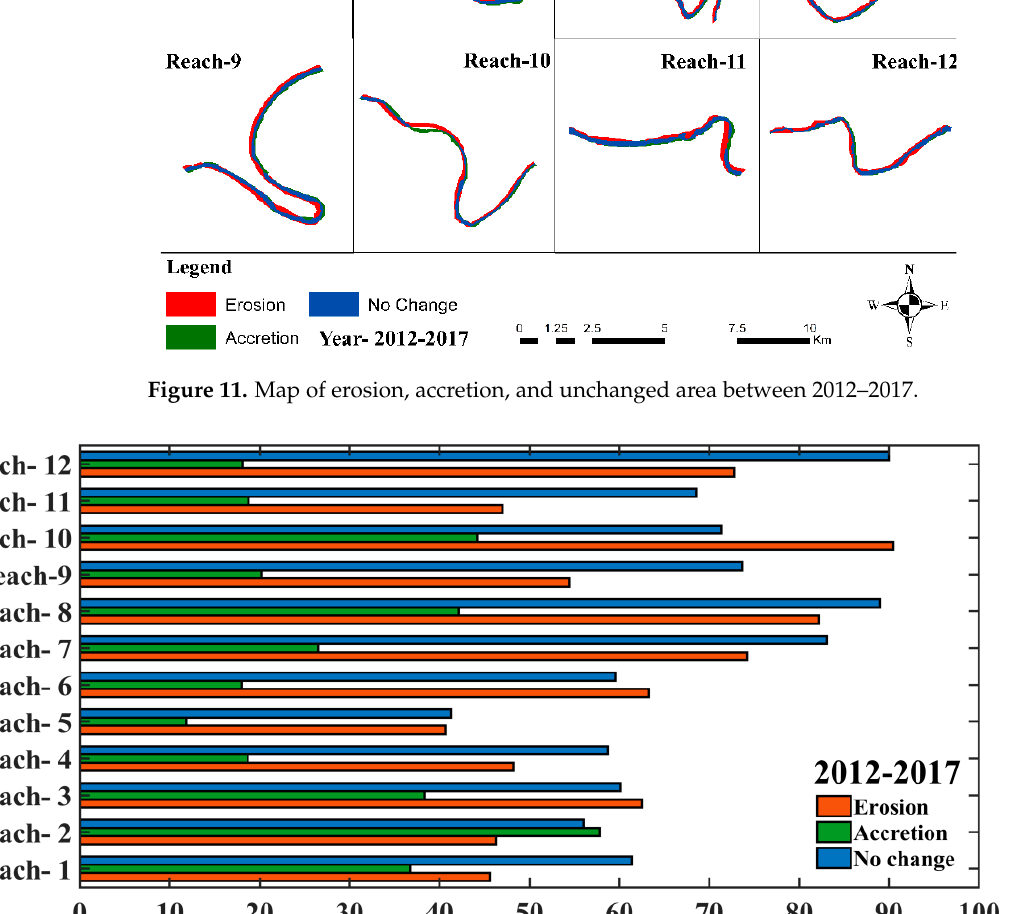
Figure 12. Erosion, accretion, and unchanged area at various reaches (1–12) between 2012–2017.